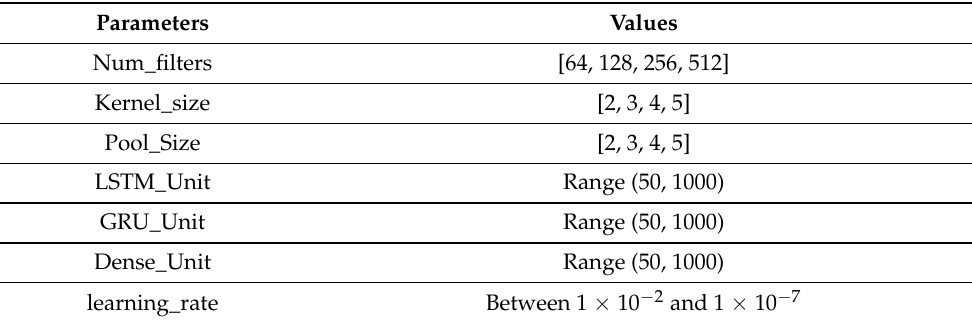
Table 1. Range of possible values for hyperparameters of DeepCNN, CNN-LSTM, and CNN-GRU DL